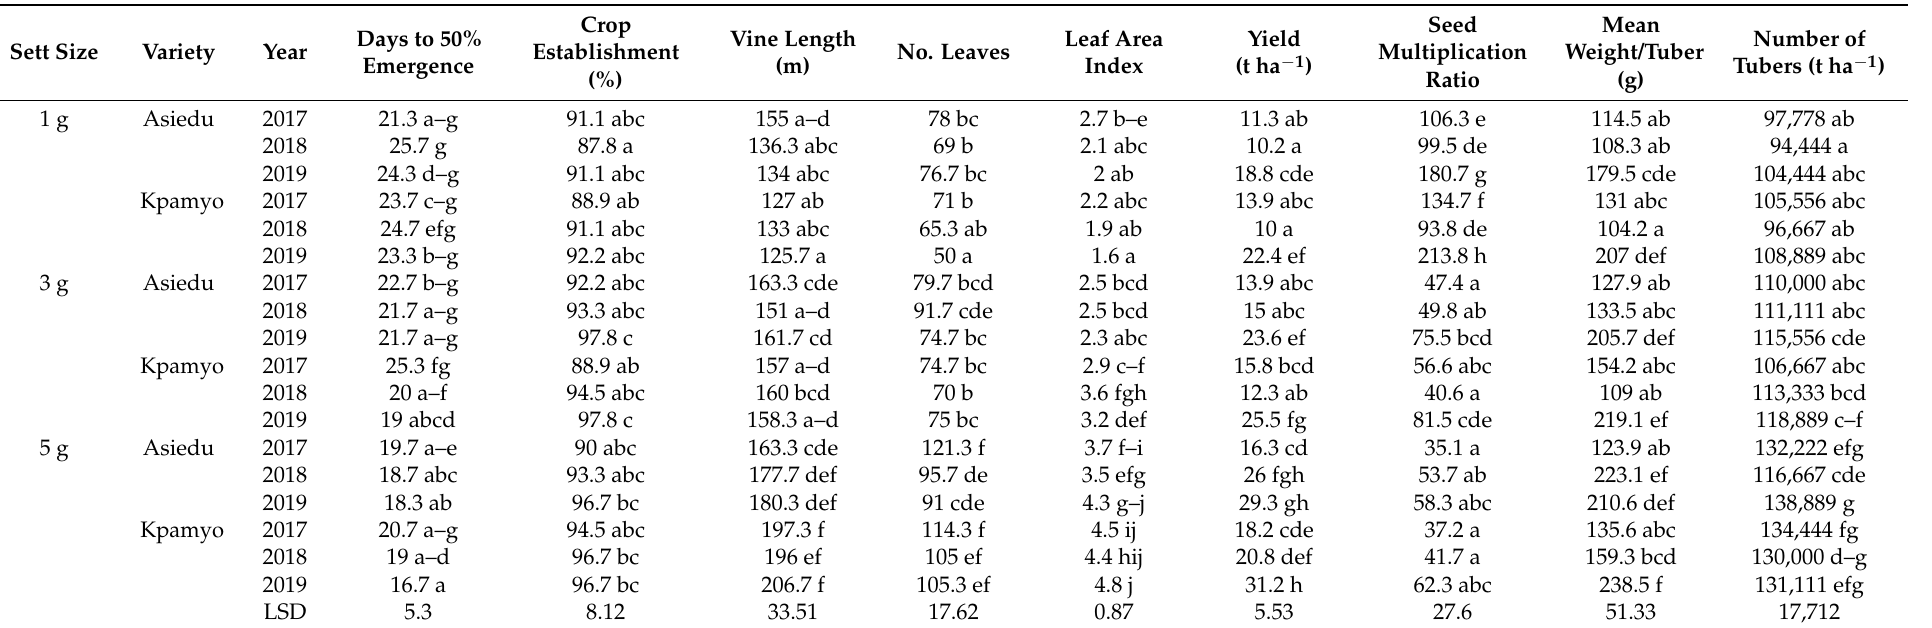
Table 2. All interactions for D. rotundata Poir. varieties planted in Abuja during the 2017, 2018, and 2019